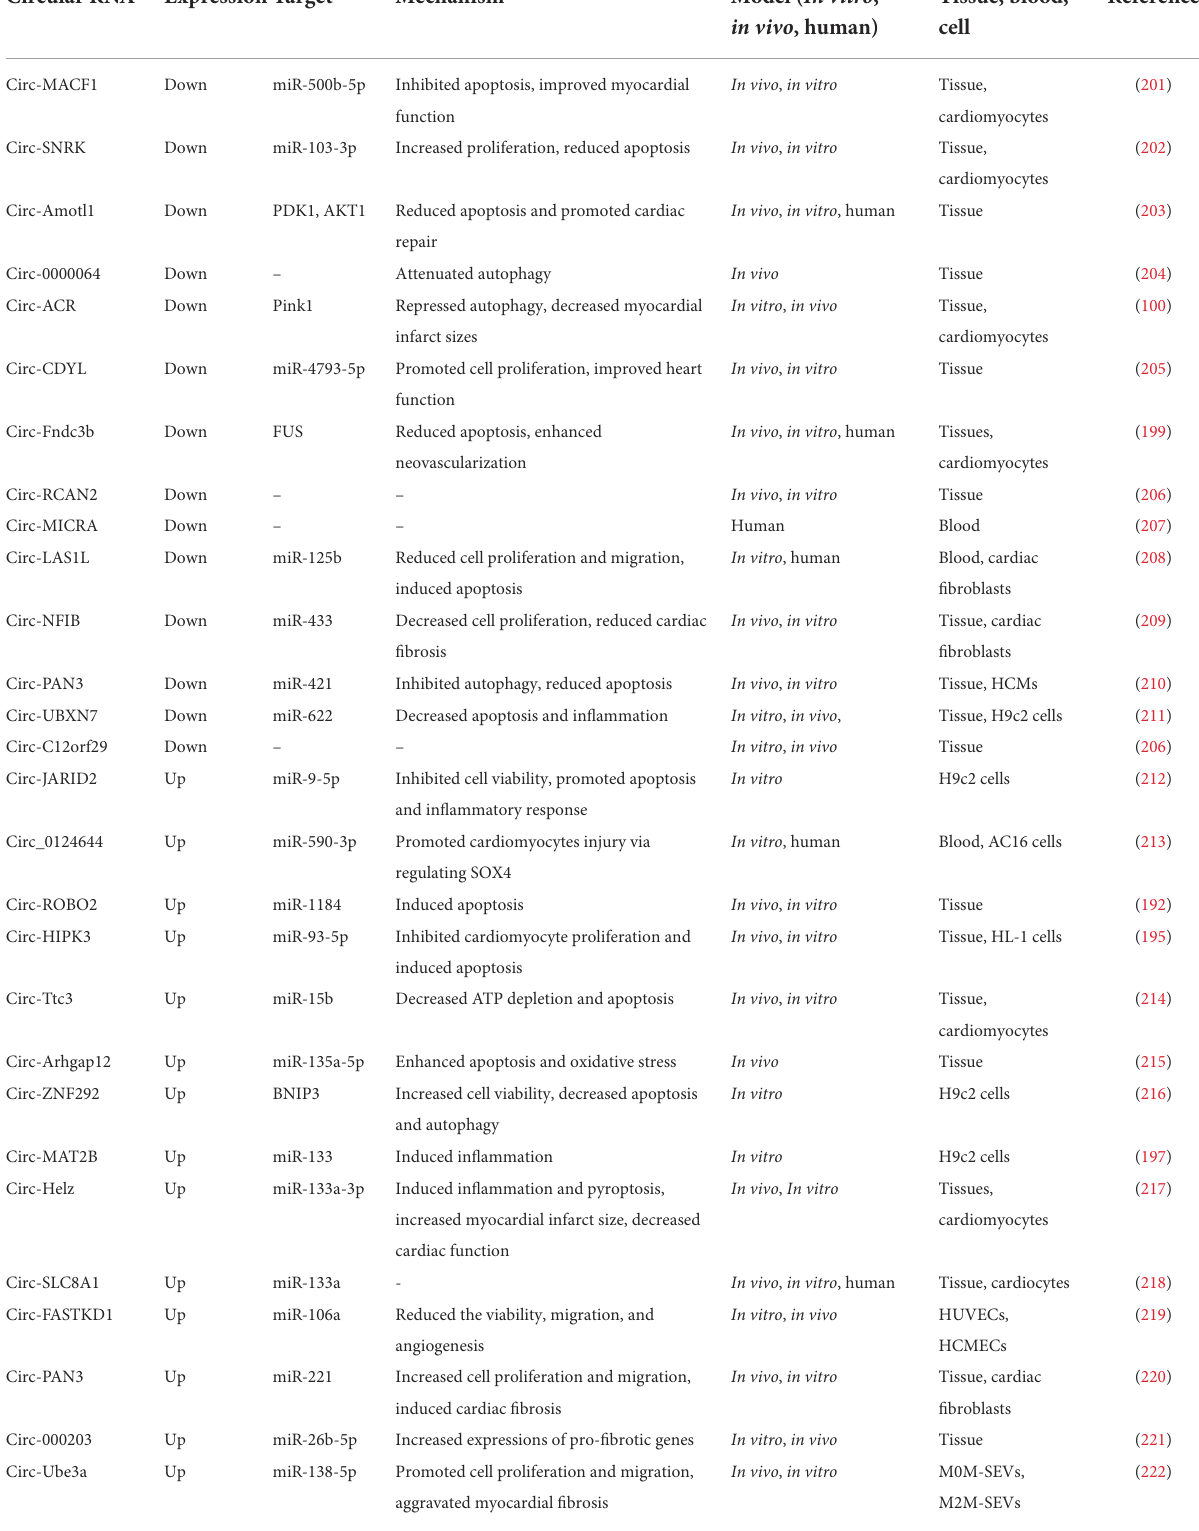
TABLE 3 Reports of changes in circRNA expression in laboratory models and patients with MI. Circular RNA Expression